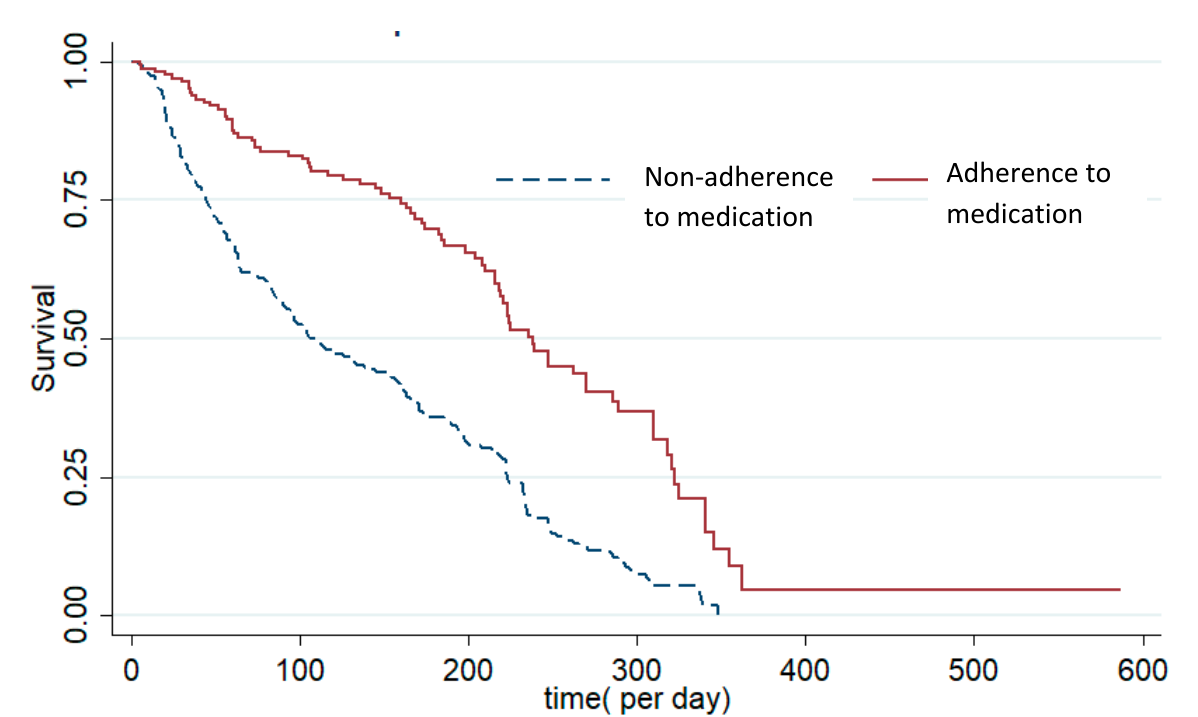
Figure 2. Survival time in days of disease in individuals with schizophrenia spectrum disorder (SSD), separately for medication adherence and medication non-adherence.